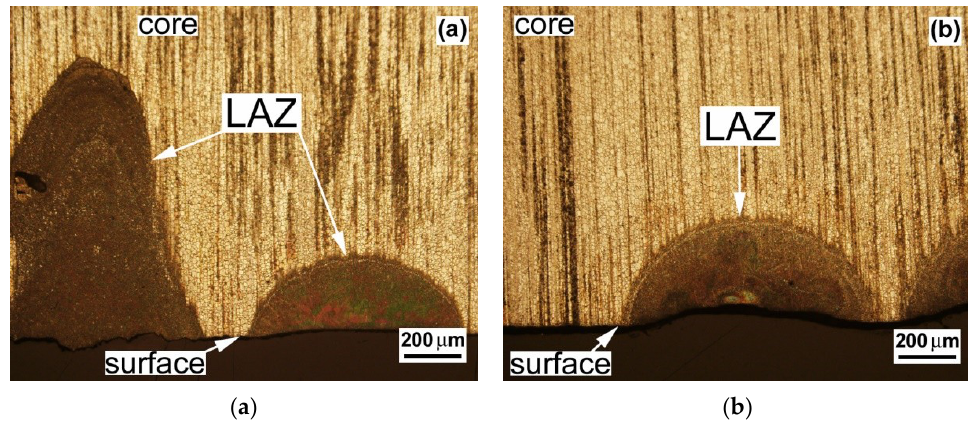
Figure 2. Light-optical micrographs showing the laser-affected zones (LAZs) created in AZ61 material after laser surface treatment at: ( a ) laser beam travel speed of 40 mm/s and laser beam defocusing of either +5 mm (left LAZ) or +10 mm (right LAZ); ( b ) laser travel speed of 20 mm/s and laser beam either + 5 mm (left LAZ) or + 10 mm (right LAZ); ( b ) laser travel speed of 20 mm / s and laser beam defocusing of +10 mm. defocusing of + 10